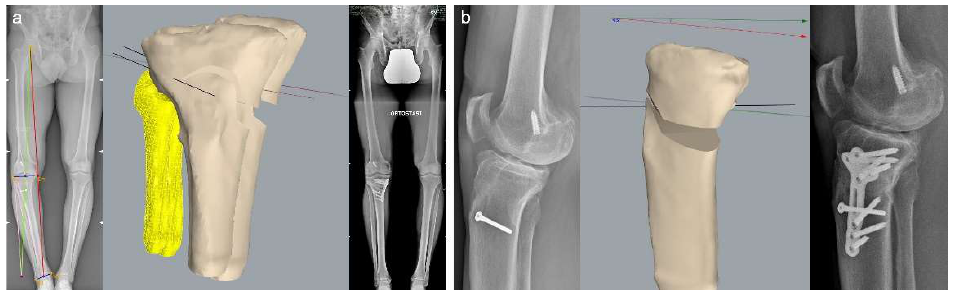
Figure 7. Patient 3 imaging; ( a ) preoperative full-length weight-bearing X-ray, 3D CT-based planning of the osteotomy and postoperative full-length weight-bearing X-ray; ( b ) preoperative lateral knee X-ray, 3D CT-based planning of the sagittal plane correction and postoperative lateral knee X-ray.